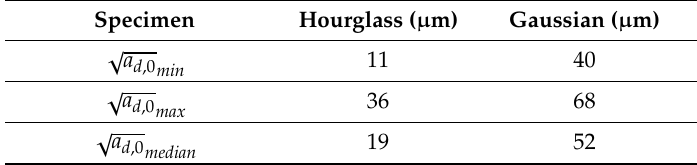
√ a d ,0 , in hourglass specimens and in Gaussian specimens. Table 2. Size of the critical defect, Specimen Hourglass ( µ